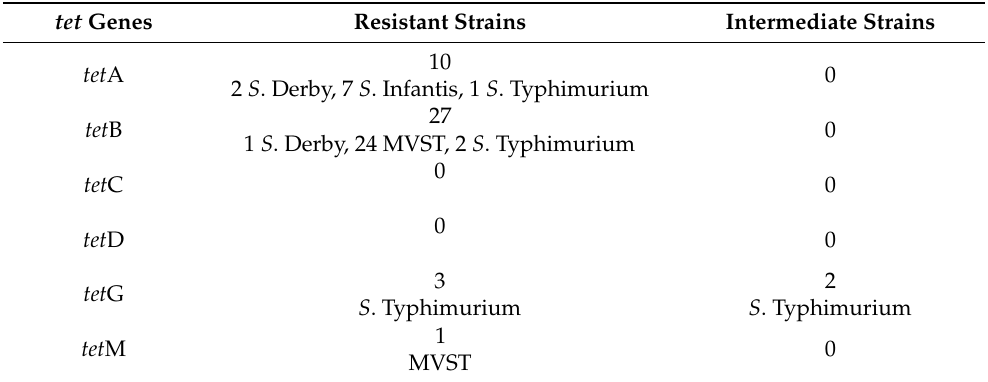
Table 2. tet genes detected in tetracycline-resistant and intermediate strains, and serovars. tet